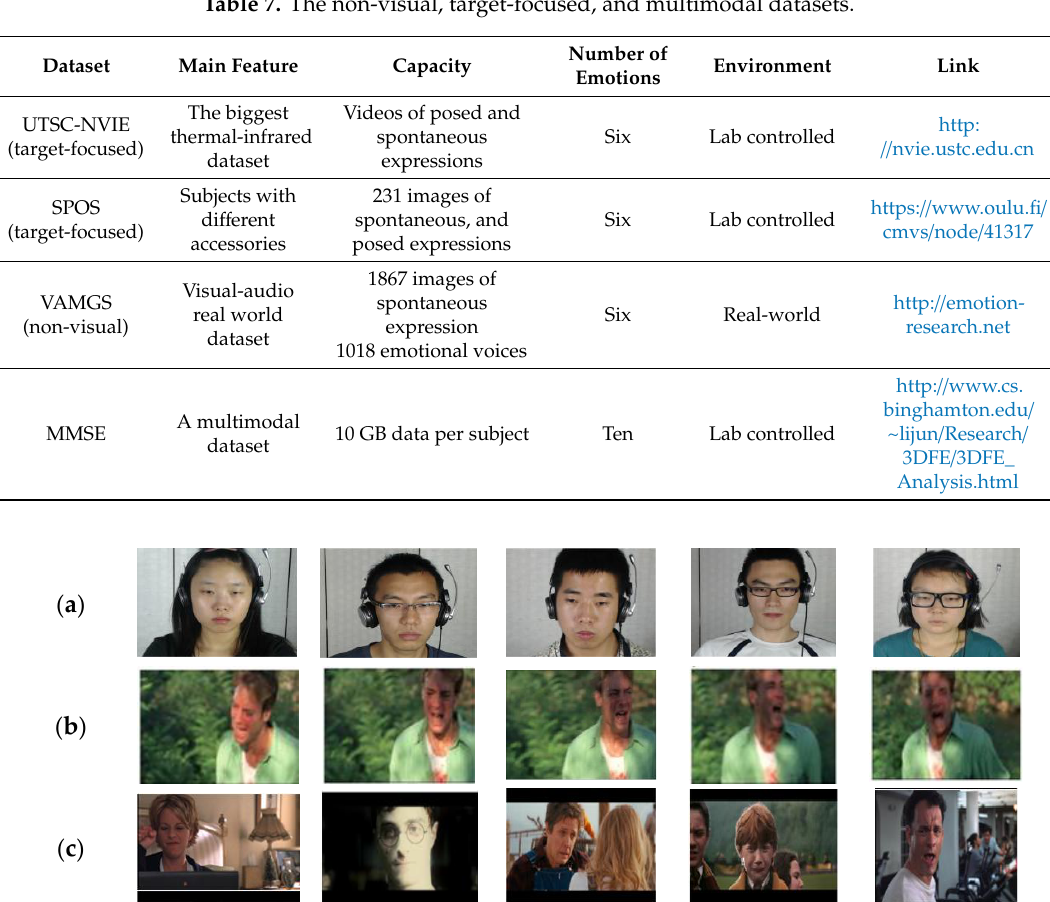
Figure 2. Example datasets: ( a ) CAS(ME) 2 , ( b ) AFEW, and ( c ) SEFW. Table 6. The camera-based datasets (under real-world and simulation of real-world conditions in the lab).